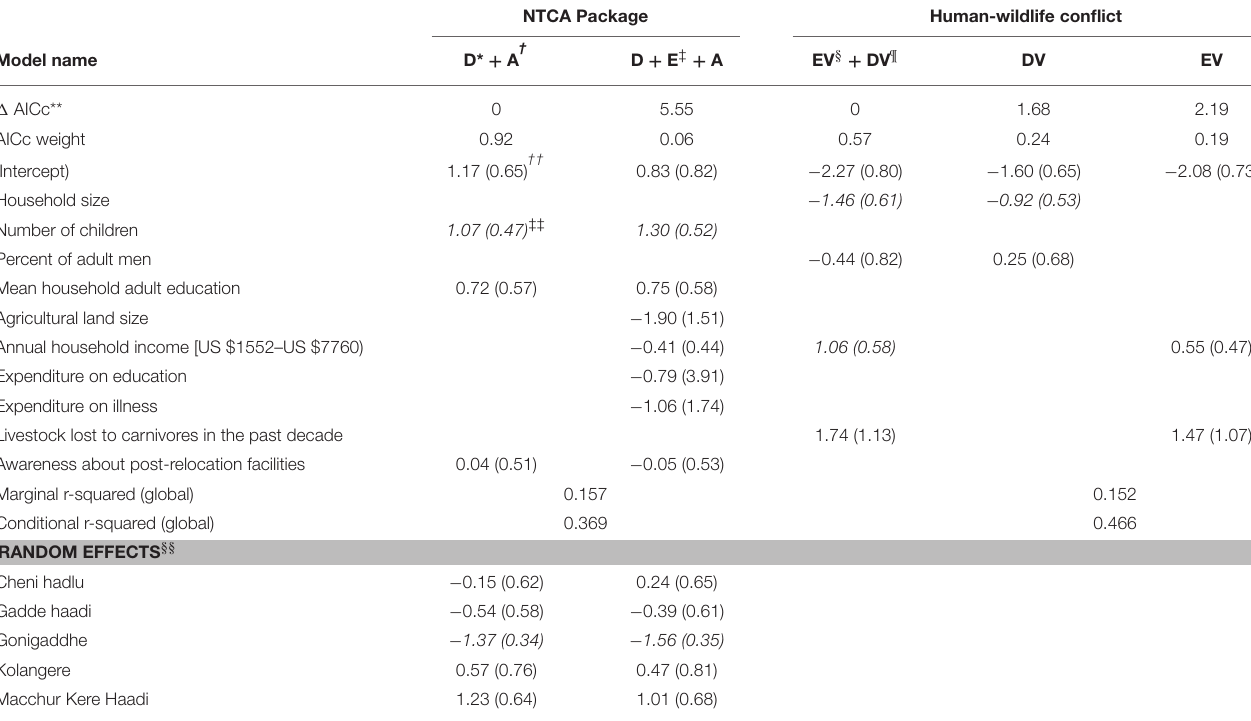
TABLE 4 | Top-ranked models (cumulative weight > 0.95) and beta estimates of fixed, and random effects for predicting the likelihood that households want to relocate to avail the benefits of the government resettlement (NTCA) package, and to minimize losses from human-wildlife conflict at Nagarahole. NTCA Package Human-wildlife